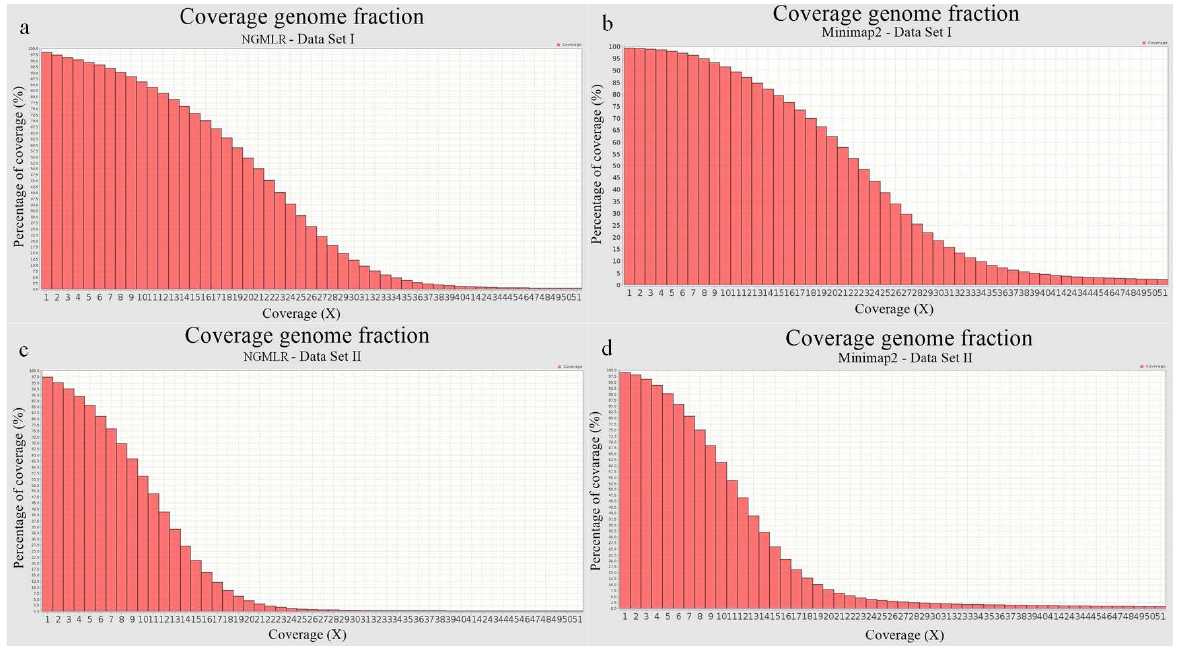
Figure 3. Genome Fraction Coverage ( y axis) and coverage level ( x axis) obtained with NGMLR ( a , c ) and minimap2 ( b , d ) by mapping the two datasets (Data set I—a and b; and Data set II—c and d) to the D. melanogaster reference genome (r6.39) (source: Qualimap).